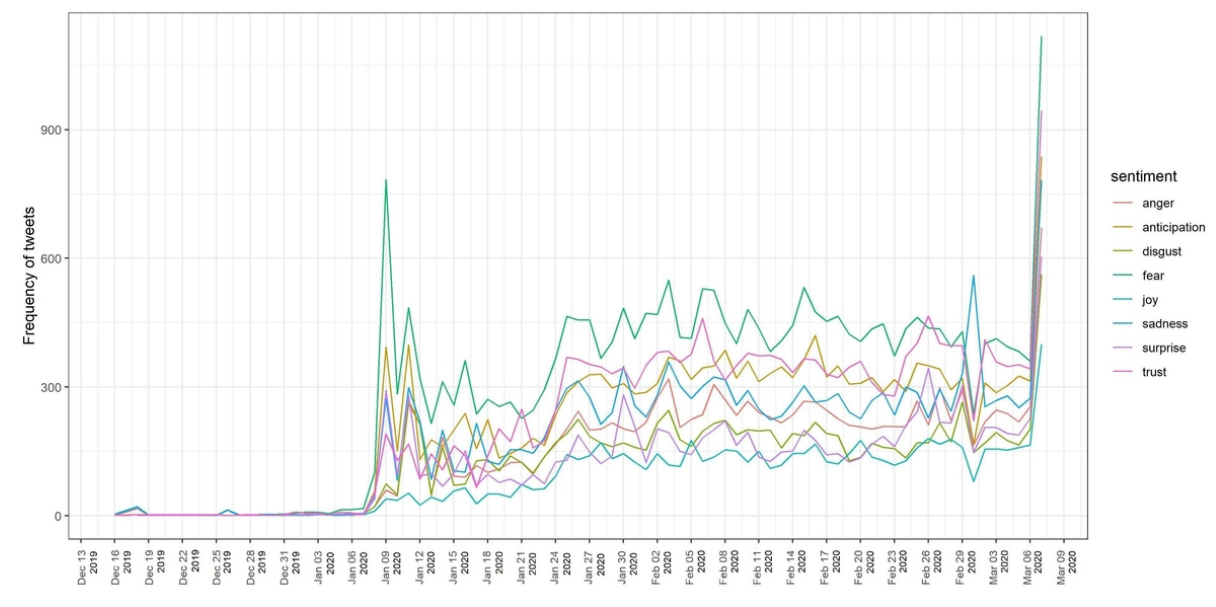
Figure 7. Sentiment analysis based on terms in the National Research Council sentiment